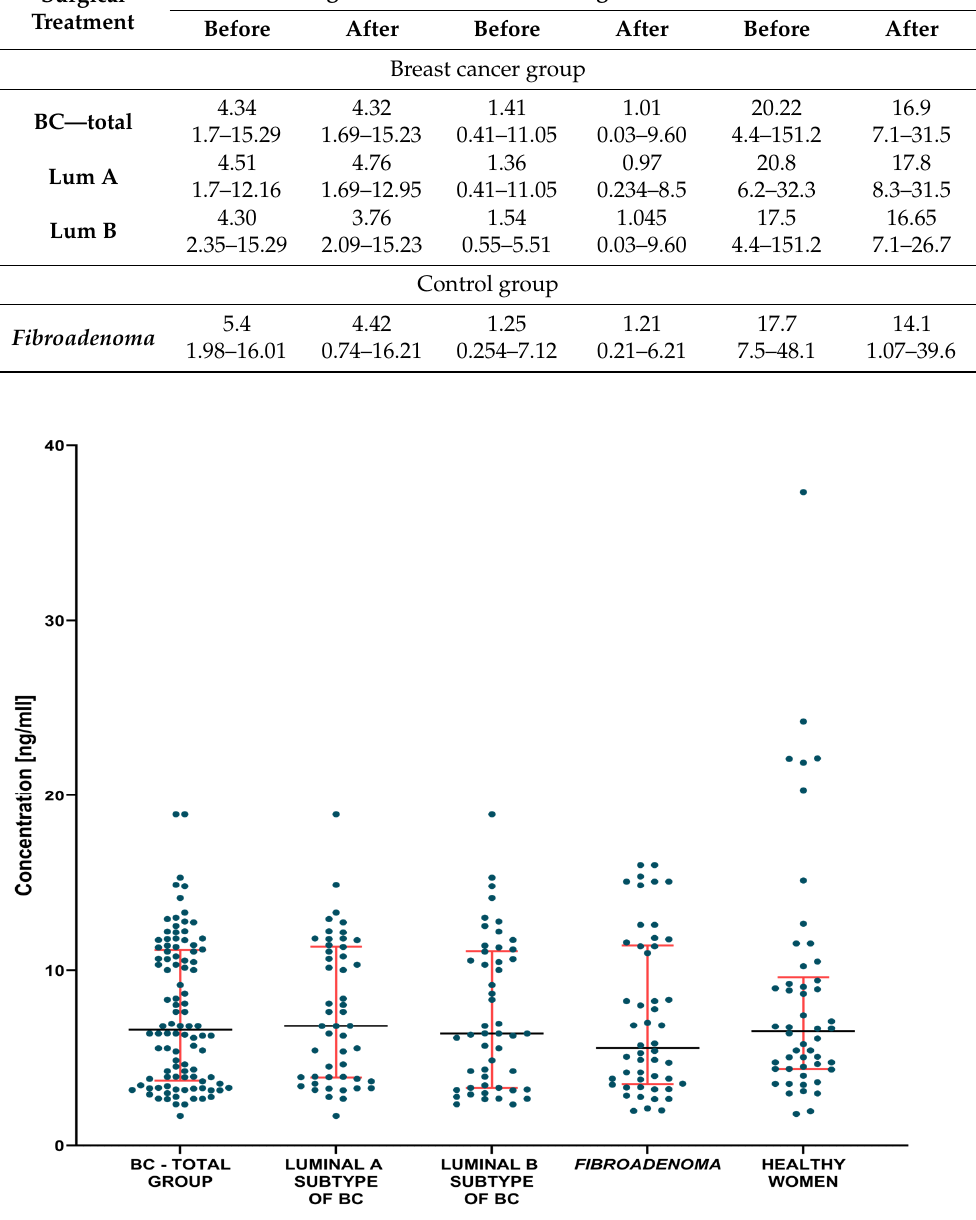
Figure 1. MMP-3 plasma concentrations (with marked median and interquartile range) in all tested groups: patients with BC, fibroadenoma subjects and healthy women.